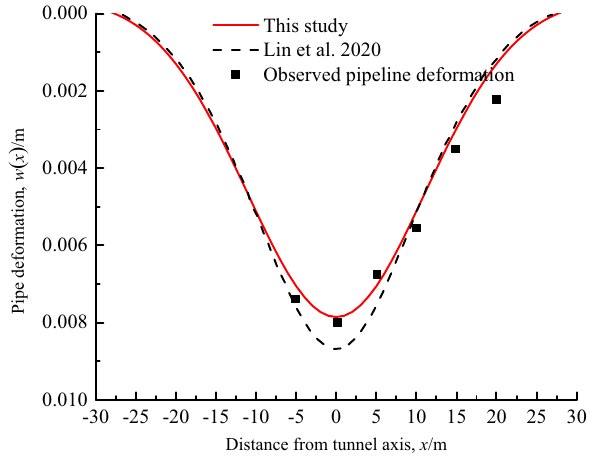
Figure 10. Comparison of calculation results of pipeline deflection.